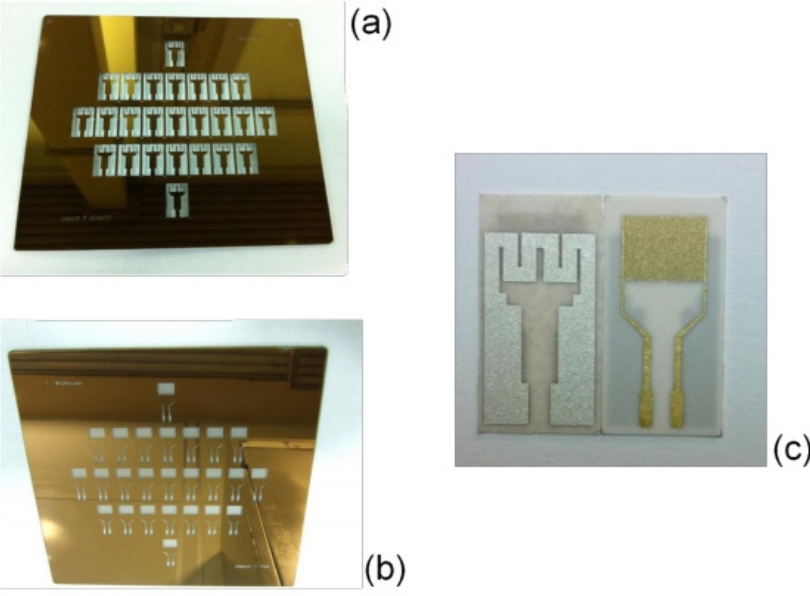
Figure 22. ( a ) Masks for heater; ( b ) masks for IDE; ( c ) the transducer prototype with platinum heater (back side) and gold IDE (front side), from ref. [126].